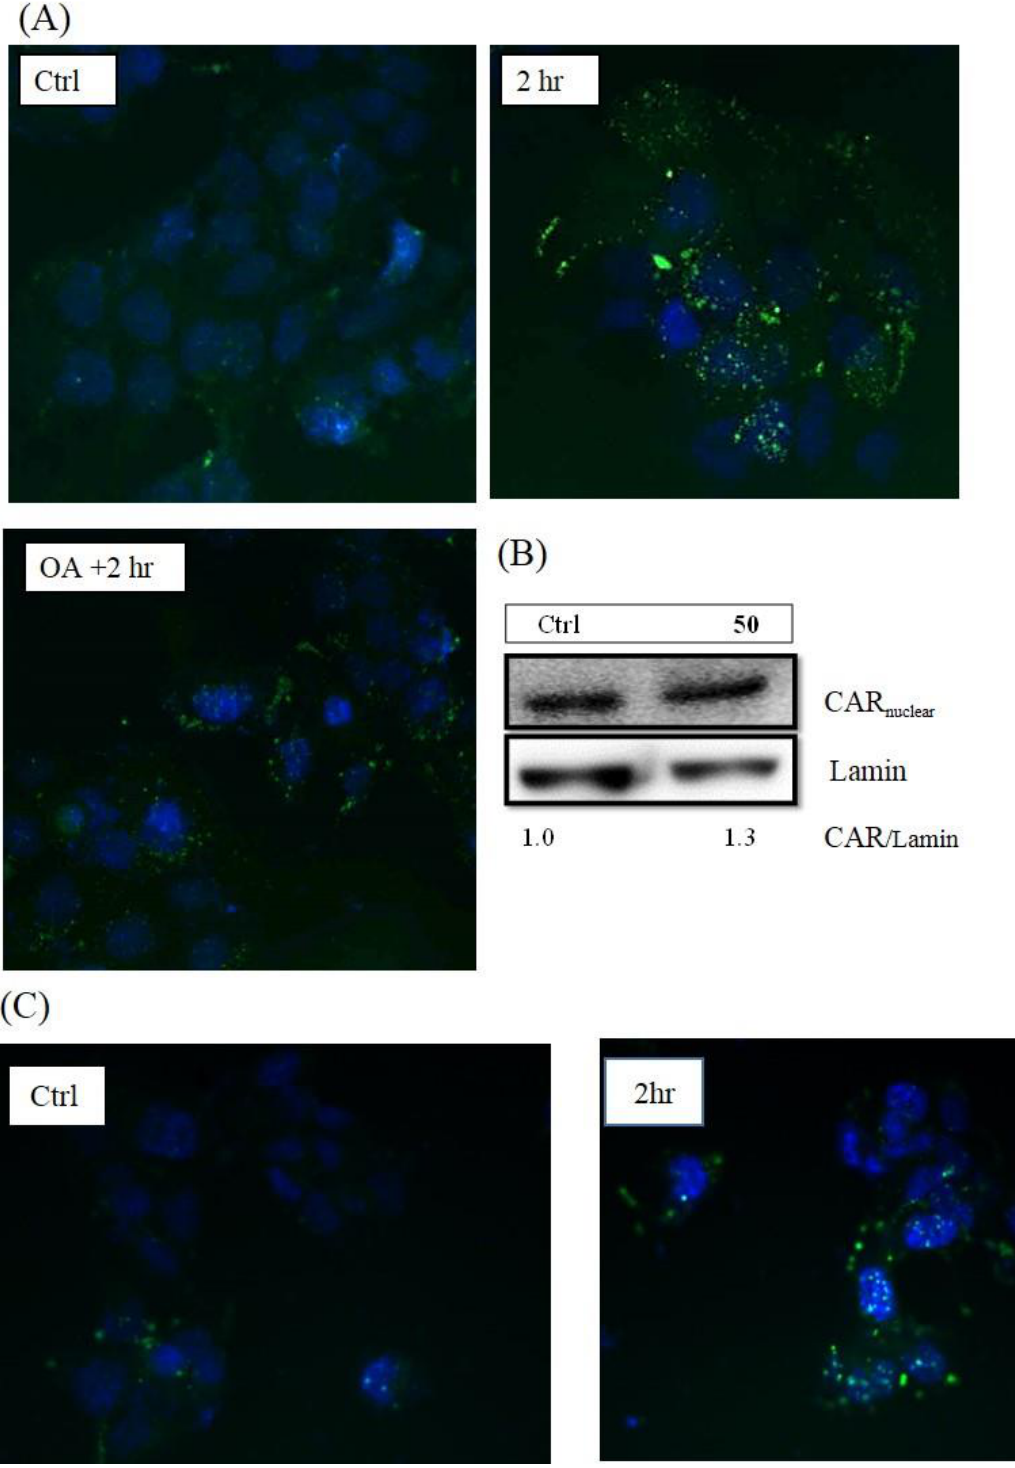
Figure 3. Image of immunofluorescence staining for CAR translocation in Hep3B cells after 6,7-diprenoxycoumarin ( 50 ) treatment ( A ) and scoparone treatment ( C ). Hep3B cells were treated with 50 (10 μM) for 2 h. The negative control group was pre-treated with 10 nM okadaic acid (OA). The blue and green fluorescence stands for signals of nuclei and CAR protein, respectively. The protein expression of nuclear CAR after 6,7-diprenoxycoumarin ( 50 ) treatment for 2 h ( B ).